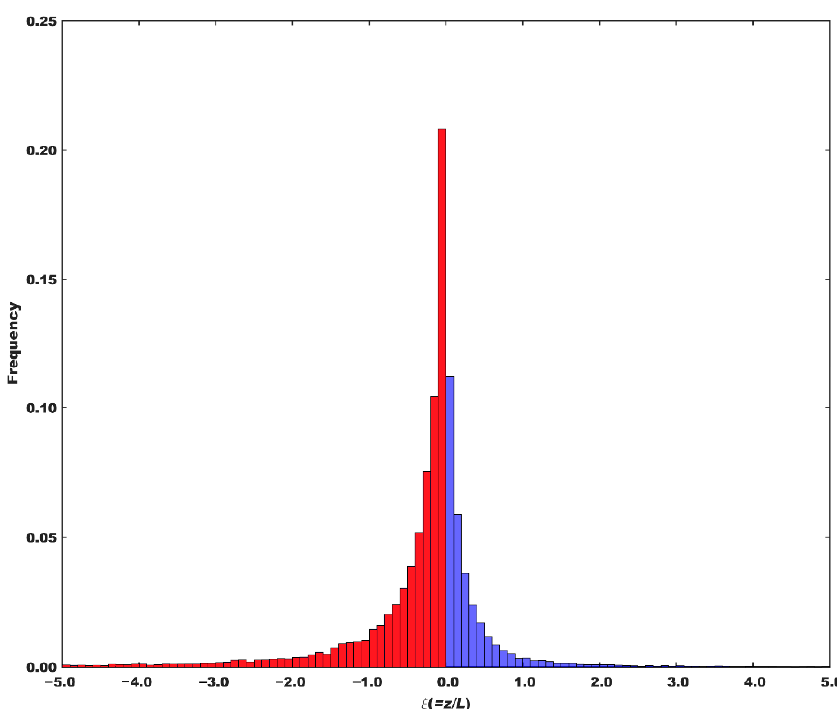
Figure 7. Frequency of the stability parameter ξ based on turbulence data at Shiquanhe. The red (blue) bars are the frequency of the unstable (stable) condition.